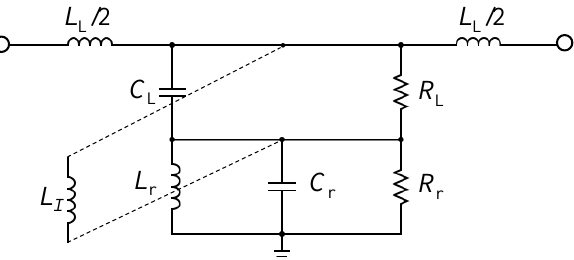
Figure 2. The proposed circuit model of the CSRR with the inserted via.